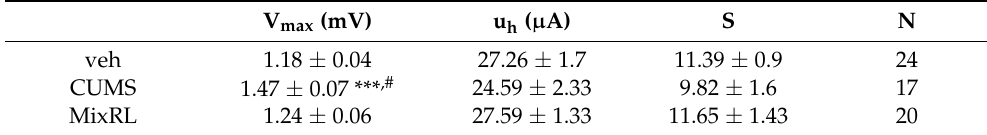
Data are presented as the means ± SEM. Threshold, stimulus intensity evoking FP of approx. 0.1 mV in amplitude; Vmax—maximum FP amplitude; uh—half maximum stimulation; S—factor proportional to the slope of the